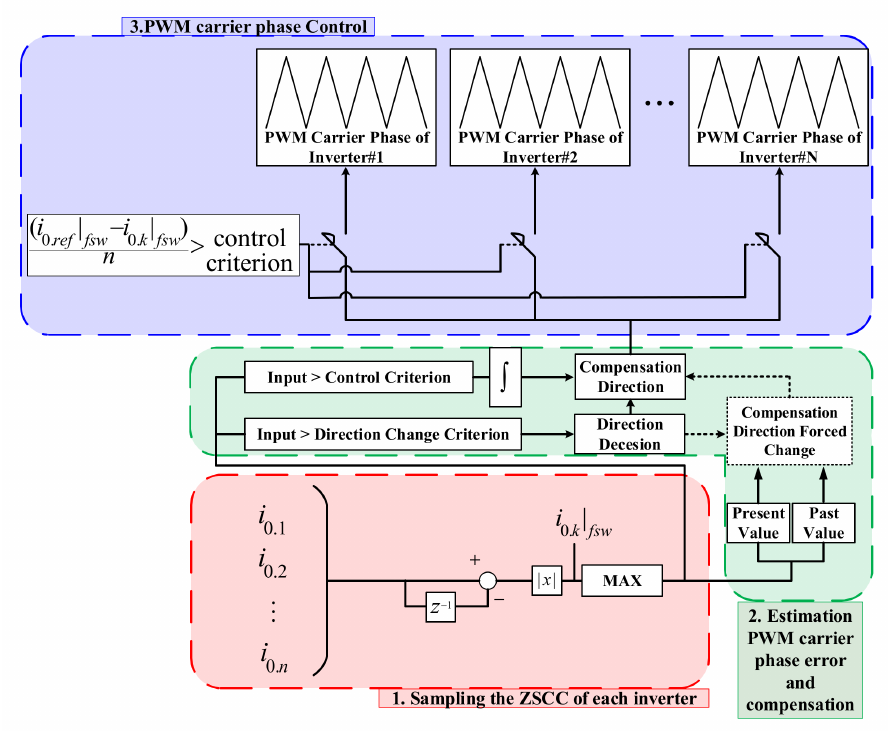
Figure 4. Control schemes for the proposed carrier error compensation